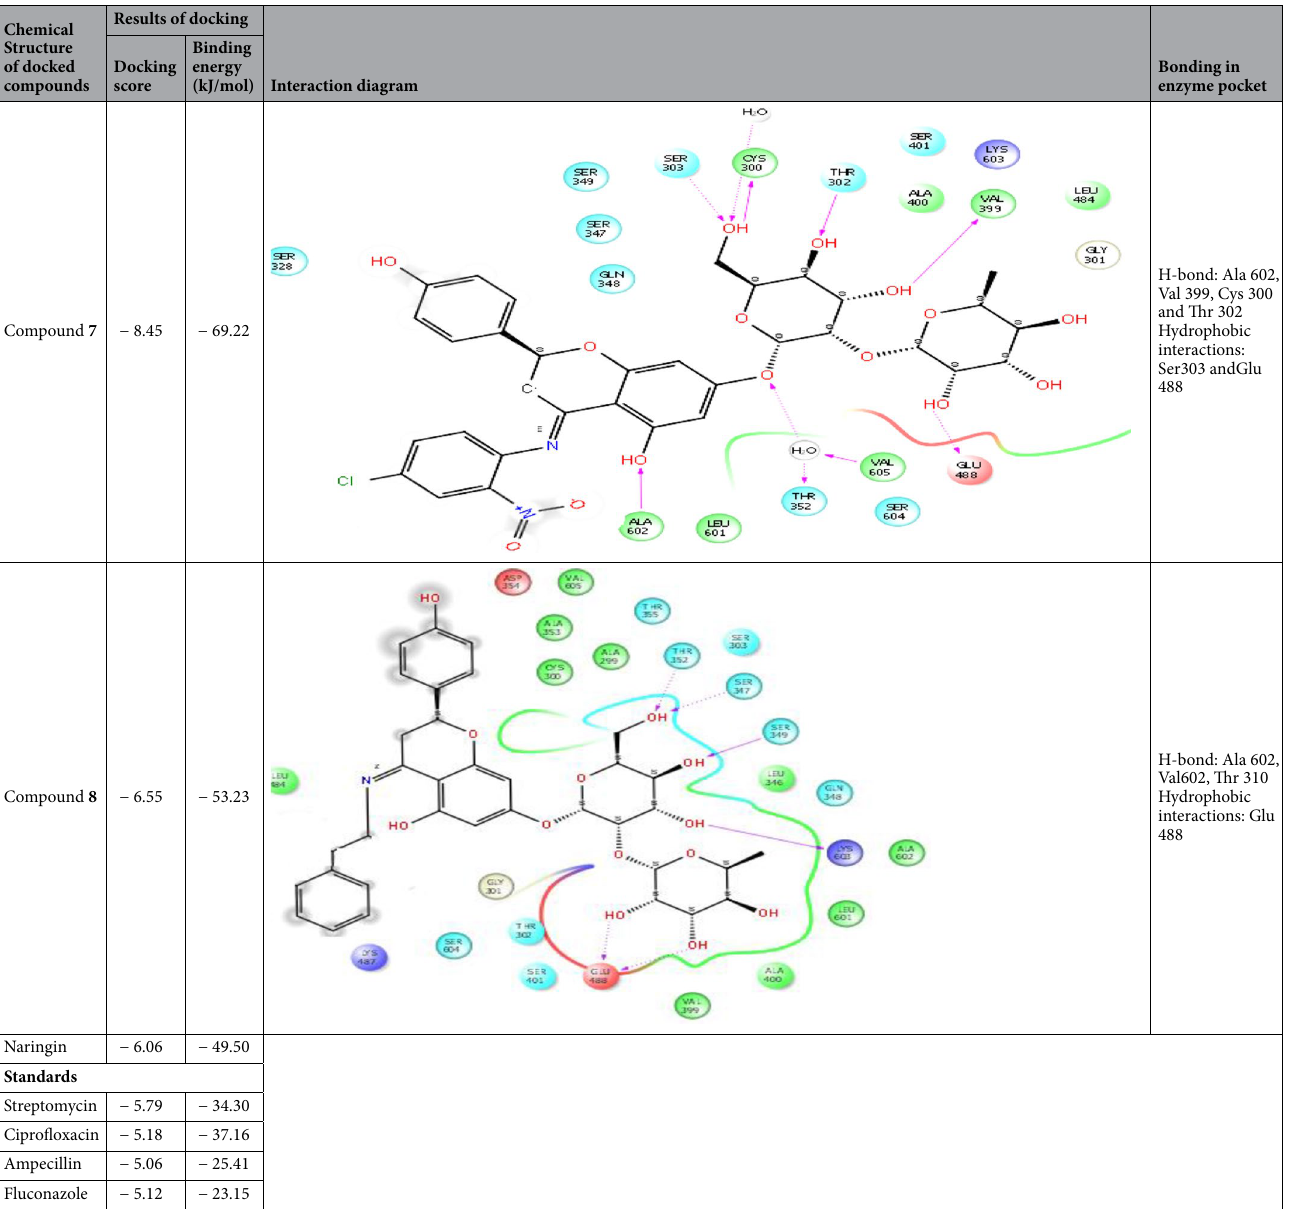
Table 1. Results of molecular docking for proposed naringin